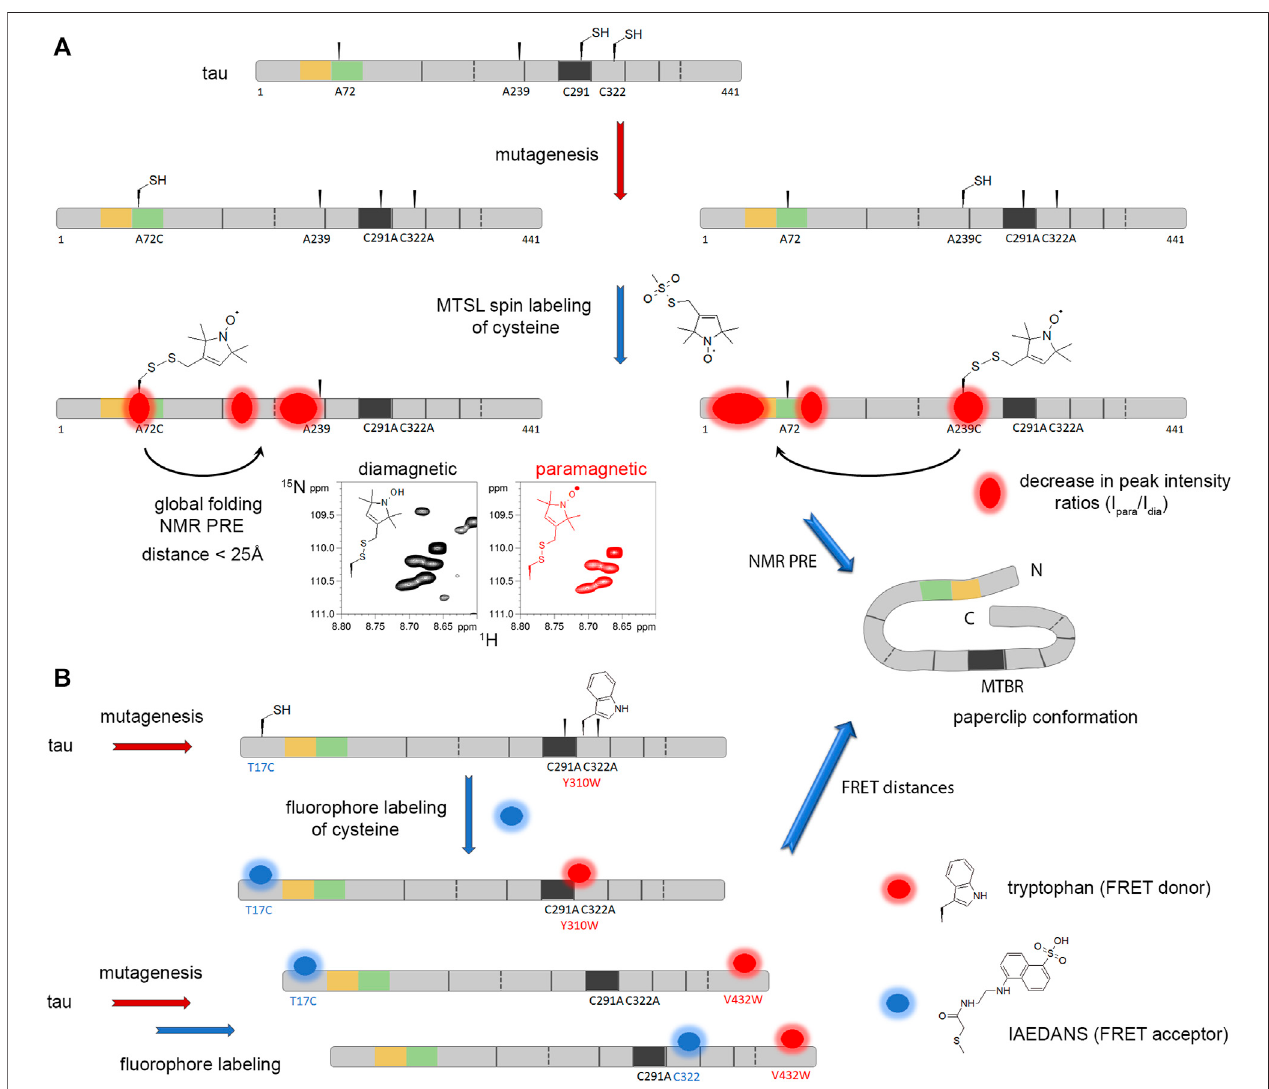
FIGURE 9 | Nitroxide spin labeling and FRET fl uorescent pair labeling for distance measurements by NMR, EPR and FRET exempli fi ed in tau protein. (A) Nitroxide spin labels such as MTSL (S-(1-oxyl-2,2,5,5-tetramethyl-2,5-dihydro-1H-pyrrol-3-yl)methyl methanesulfonothioate) can be introduced on thiolfunction(s) of engineered cysteine residues obtained by site-directed mutagenesis for NMR experiments. Single spin label is used in paramagnetic relaxation enhancement (PRE) experiments. Doublespinlabelingoftwodistinctcysteineresiduesisusedforparamagneticrelaxationinterference(PRI)experiments(notshowninthe fi gure).Thesamelabeling strategy with single or double paramagnetic probes can be used in EPR experiments (not shown in the fi gure). Single spin labels are introduced at different positions alongtheprotein sequence asillustrated by A72C and A239C labeling. Proximal and long-rangeperturbations ofNMR signals (distance > 10 Åupto25 Å) from thespin label is indicated by red areas (Bibow et al., 2011). The PRE phenomenon is characterized by a selected decrease of peak intensities in the 1 H- 15 N HSQC experiment acquired on the 15 N-uniformly labeled protein and quanti fi ed by the I para /I dia ratio corresponding to the intensities measured in the paramagnetic specie (I para ) and the intensities measured in the diamagnetic specie (I dia ) inwhich the nitroxide is reduced by vitamin C. Such a spatial proximityto the probe ofremote residues in the protein sequence suggests an overall folding of tau protein in its native monomeric form such as the paperclip-like conformation. (B) FRET measurement of distances requires both the mutagenesis of a hydrophobic amino acid into tryptophan as FRET donor probe (red spot) and coupling of IAEDANS as FRET acceptor probe (blue spot) to either a native (C322) or engineered cysteine (T17C) of tau protein. Different combinations of positions of FRET donor and acceptor probes allowed to de fi ne the paperclip conformation of native monomeric tau where both N- and C-termini are in close proximity of the central MTBR functional domain (Jeganathan et al., 2006; Jeganathan et al.,